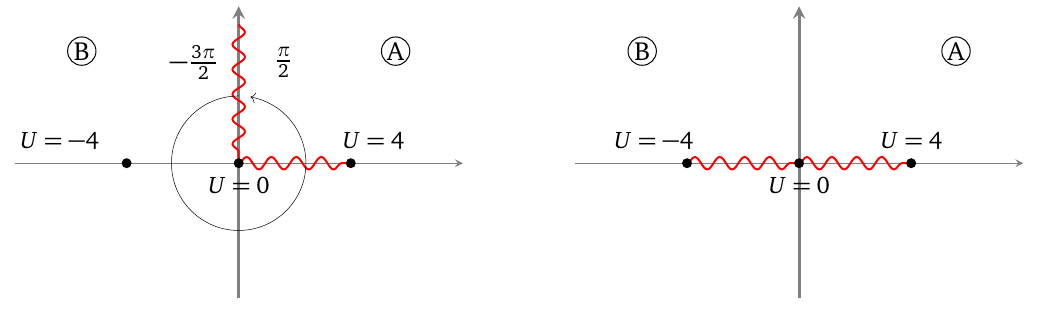
Figure 13: Branch cuts for